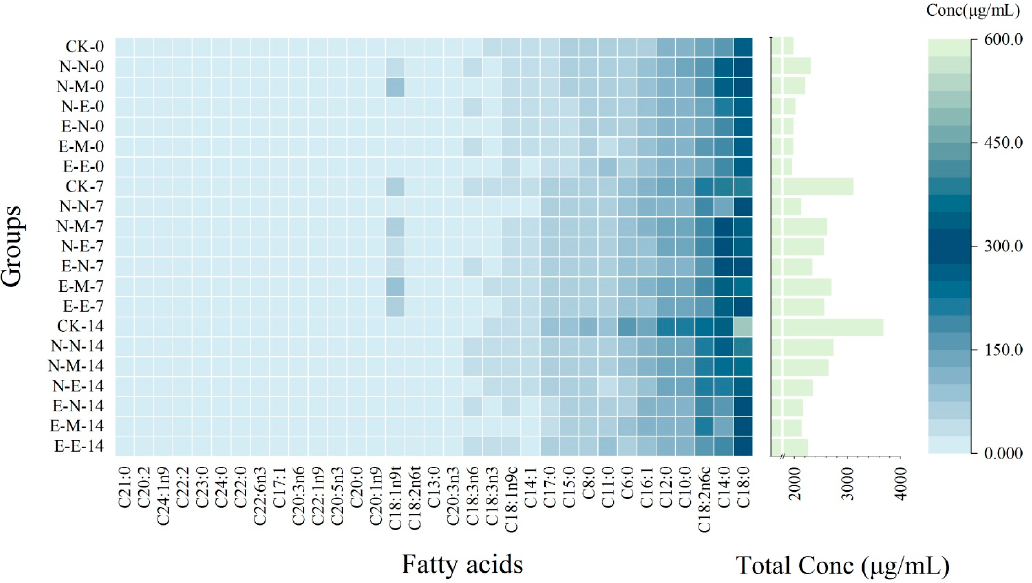
Figure 7. Fa tt y acid of freeze–thawed Mongolian cheese after 30 days of storage at − 30 °C.